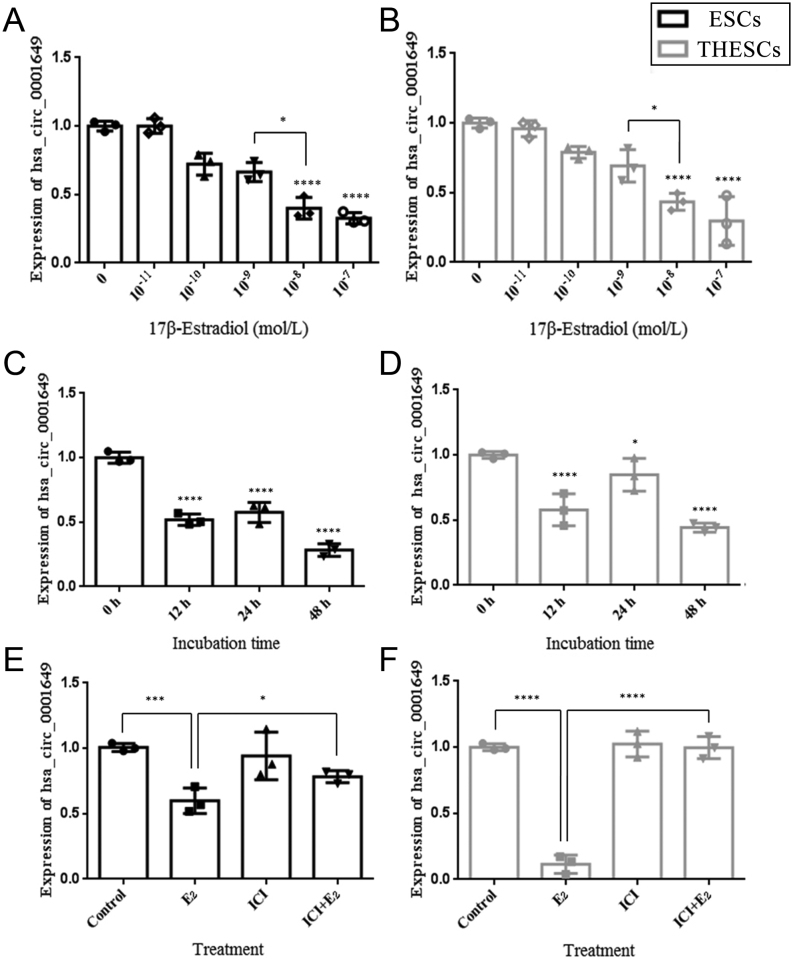
Hsa_circ_0001649 expression is regulated by estrogen (E2) in human primary endometrial stromal cells (ESCs) and a human endometrial stromal cell line (ThESCs). (A and B) Hsa_circ_0001649 expression in ESCs and ThESCs was determined by qRT-PCR following treatment with E2 at a series of concentrations (0, 10−11, 10−10, 10−9, 10−8, and 10−7 mol/L). (C and D) Hsa_circ_0001649 expression in ESCs and ThESCs was determined following 10−8 mol/L E2 treatment for the indicated durations (0, 12, 24, and 48 h). (E and F) Hsa_circ_0001649 expression was determined following vehicle, 10−8 mol/L E2, 10−6 mol/L estrogen receptor antagonist ICI 182,780 (ICI) and 10−8 mol/L E2 + 10−6 mol/L ICI stimulation for 48 h. The data are expressed as the mean ± s.d. of three independent experiments. *P < 0.05; ***P < 0.001 and ****P < 0.0001 by one-way ANOVA.